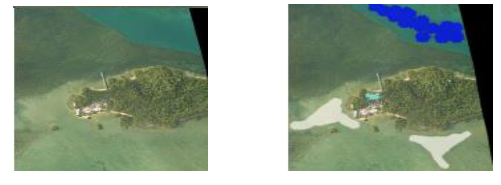
Figure 9. Sample 3D Plots of Different Features used in SVM Optimization in Matlab